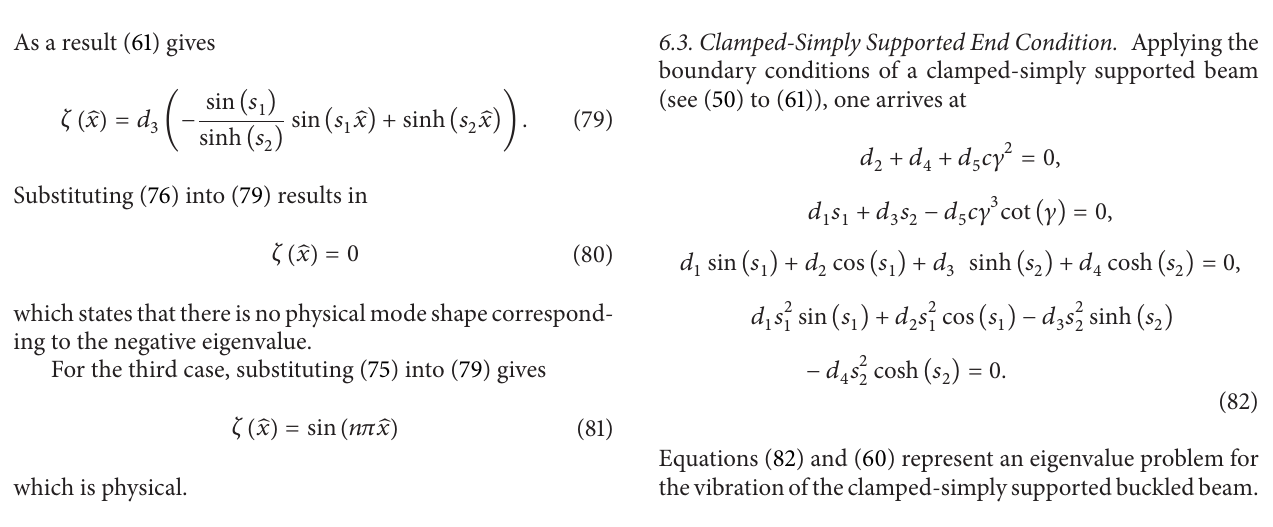
Figure 6: Variation of the nondimensional deflection ( ̂𝑥 = 0.25 ) of (a) clamped-clamped, (b) clamped-simply supported, (c) simply supported-simply supported FG beam with the temperature parameter for different values of 𝑙/ℎ ( 𝑘 = 1 , 𝐿/ℎ = 40 , second buckling